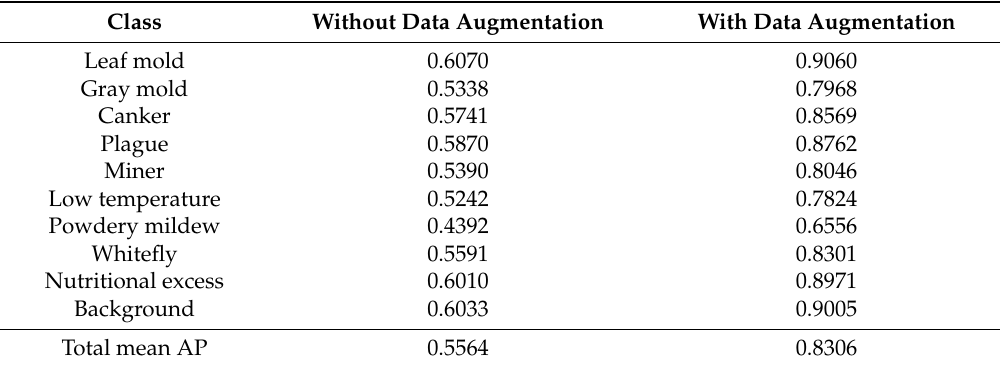
Table 5. Influence of the Data Augmentation Technique in the Final Results 1 .